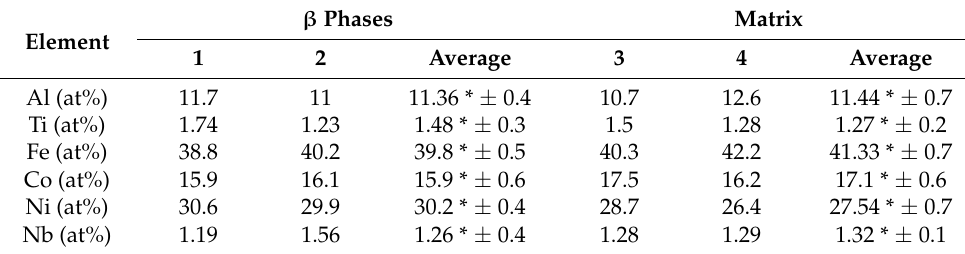
Table 2. The composition measurements of the FeNiCoAlTiNb alloy after 600 ◦ C—96 h. β Phases Element